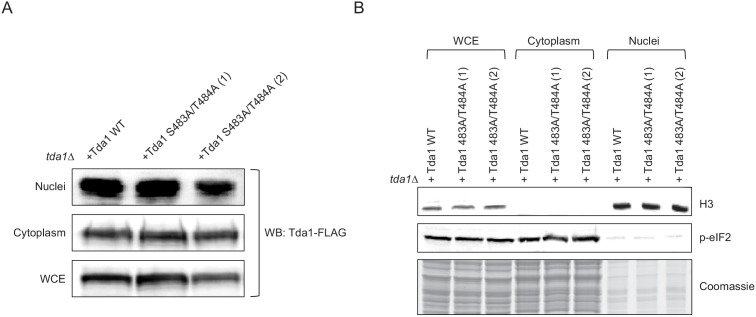
Tda1 S483/T484 phosphorylation by Snf1 is required for the nuclear Tda1 activity.(A) Subcellular localization of Tda1 WT and Tda1 S483A/T484A proteins tagged with C-terminal 3xFLAG tag measured by western blot. The cells were taken from YPgly media cultures incubated for 2 hr after the media shift from YPD. (B) 0.5% of whole-cell extract (WCE), 0.5% of cytoplasm, and 1% of nuclei samples used in (A) were subjected to western blots to confirm efficient subcellular fractionation. Histone H3 and p-eIF2 antibodies were used as the nuclear and cytoplasmic markers, respectively.